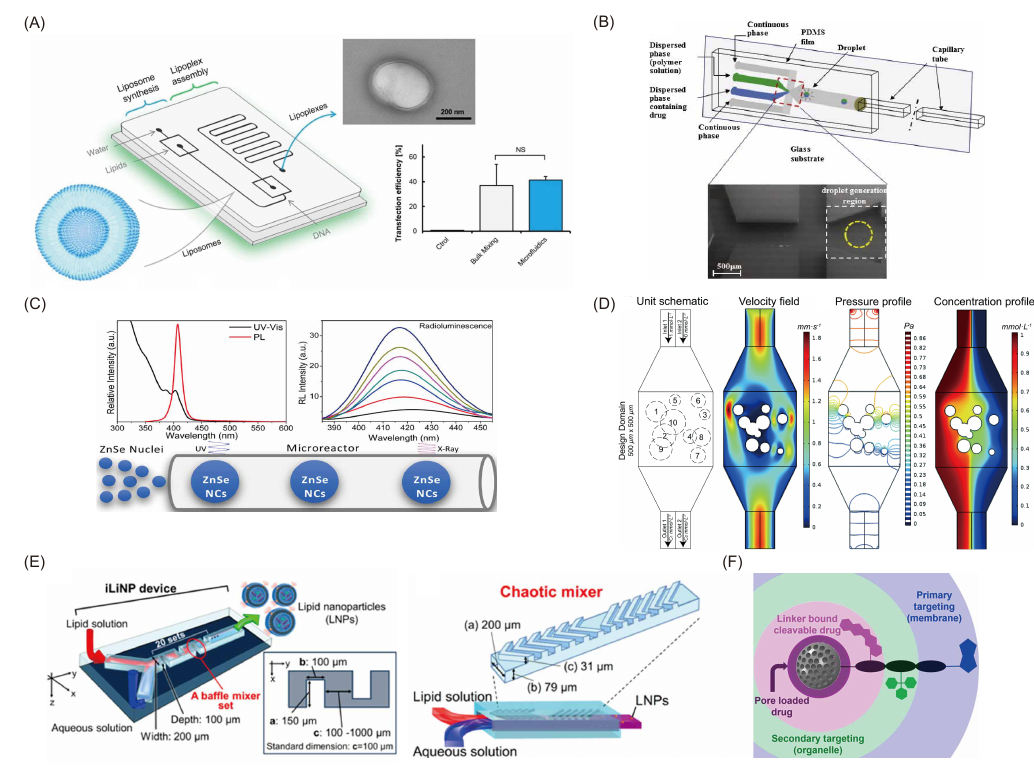
Figure 1. Different approaches for the fabrication of nanoparticles. ( A ) Schematic of the microfluidic device for one-step formation of plasmid DNA (pDNA)/cationic liposome (CL) lipoplexes and its in vitro efficacy. ( B ) Schematic of the flow-focusing device used to engineer and monitor Janus drug particle formation. ( C ) Schematic of the microfluidic reactor used for the synthesis of ZnSe quantum dots. ( D ) The simulated microfluidic mixer unit with two inlets and two outlets. ( E ) Three-dimensional views and top views of the iLiNP device. ( F ) The strategy employed for dual-targeted two-drug nanocarriers based on mesoporous silica nanoparticles. ( A ) Balbino et al. [27]; ( B ) Sundararajan et al. [31]; ( C ) Guidelli et al. [36]; ( D ) Wang et al. [24]; ( E ) Kimura et al. [21]; ( F ) Castillo et al.